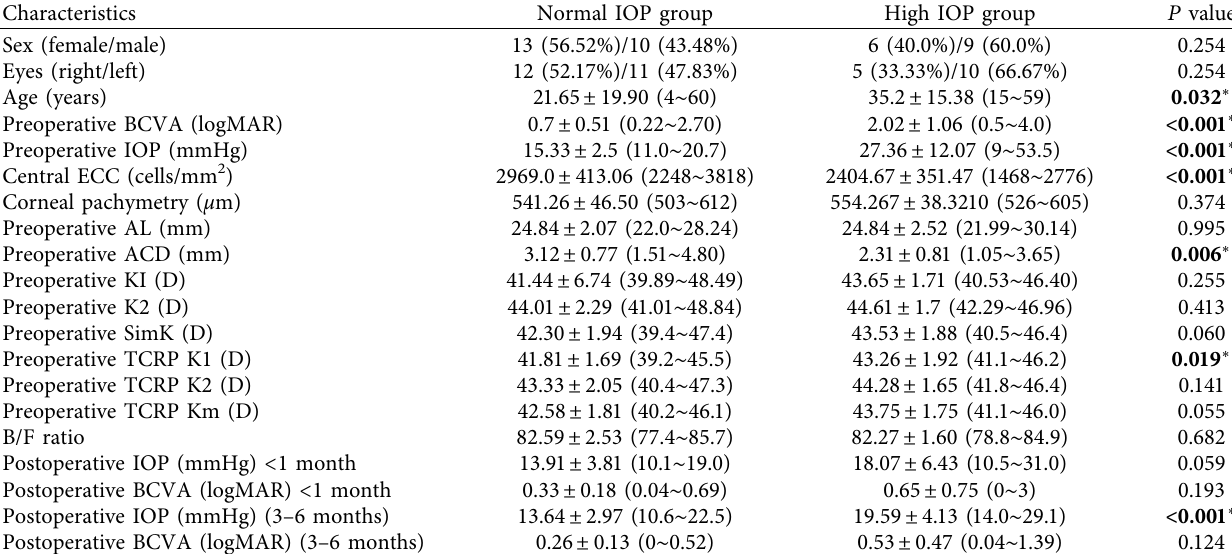
Table 2: Differences of high IOP group and normal IOP